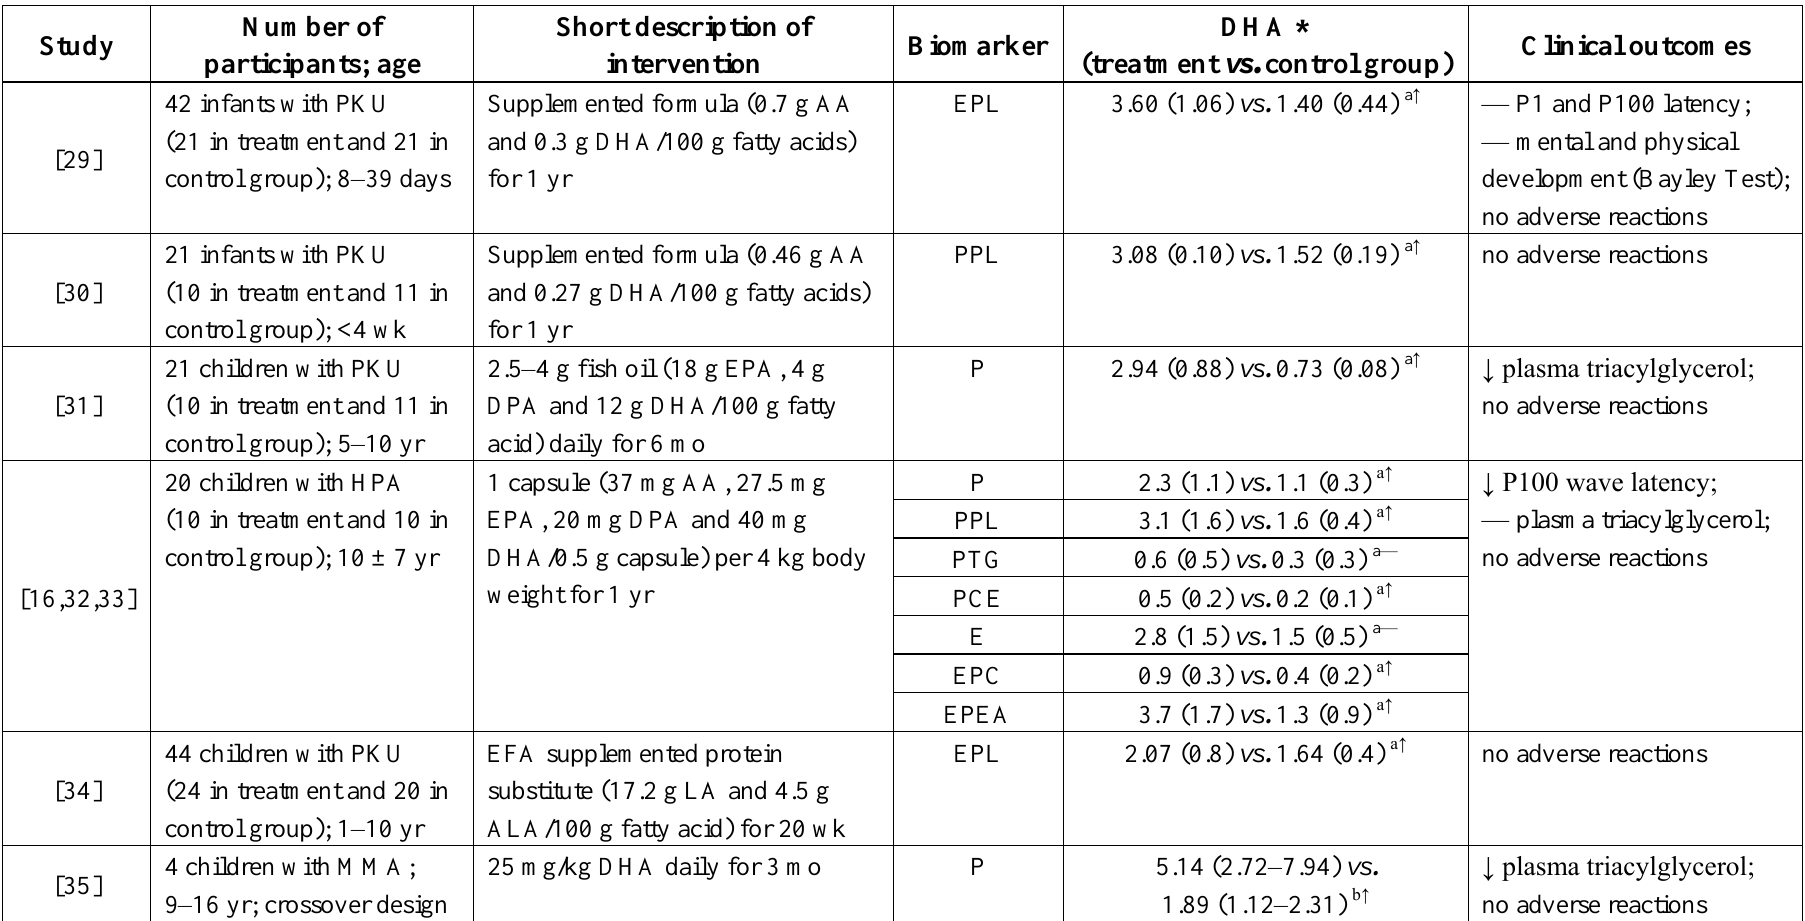
Table 2. Randomized controlled trials on the effect of long-chain polyunsaturated fatty acid supplementation in inborn errors of metabolism. *: % DHA/total fatty acid composition; a: mean (SD); b: mean (range); ↑: significant increase (p < 0.05) in the supplemented group compared with the control group at the end of the intervention; ↓: significant decrease (p < 0.05) in the supplemented group compared with the control group at the end of the intervention; —: no significant difference between the treatment and the control group at the end of the